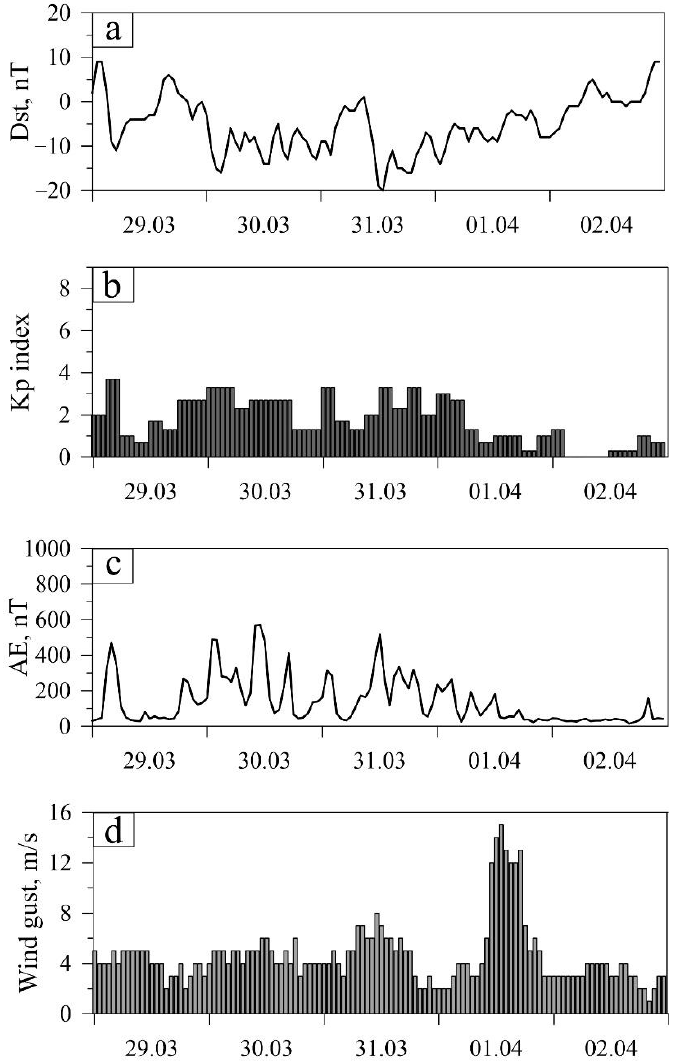
Figure 1. Geomagnetic conditions according to the SPDF-OMNIWeb service in the period from 29 March to 2 April 2016: ( a ) Dst index values; ( b ) the values of the Kp index; ( c ) the values of the AE index. Wind gusts ( d ) in Kaliningrad (Russia, 54.7° N, 20.5° E) at the same period according to the data from meteorological radar in Khrabrovo (Russia, 54.8° N, 20.5° E).